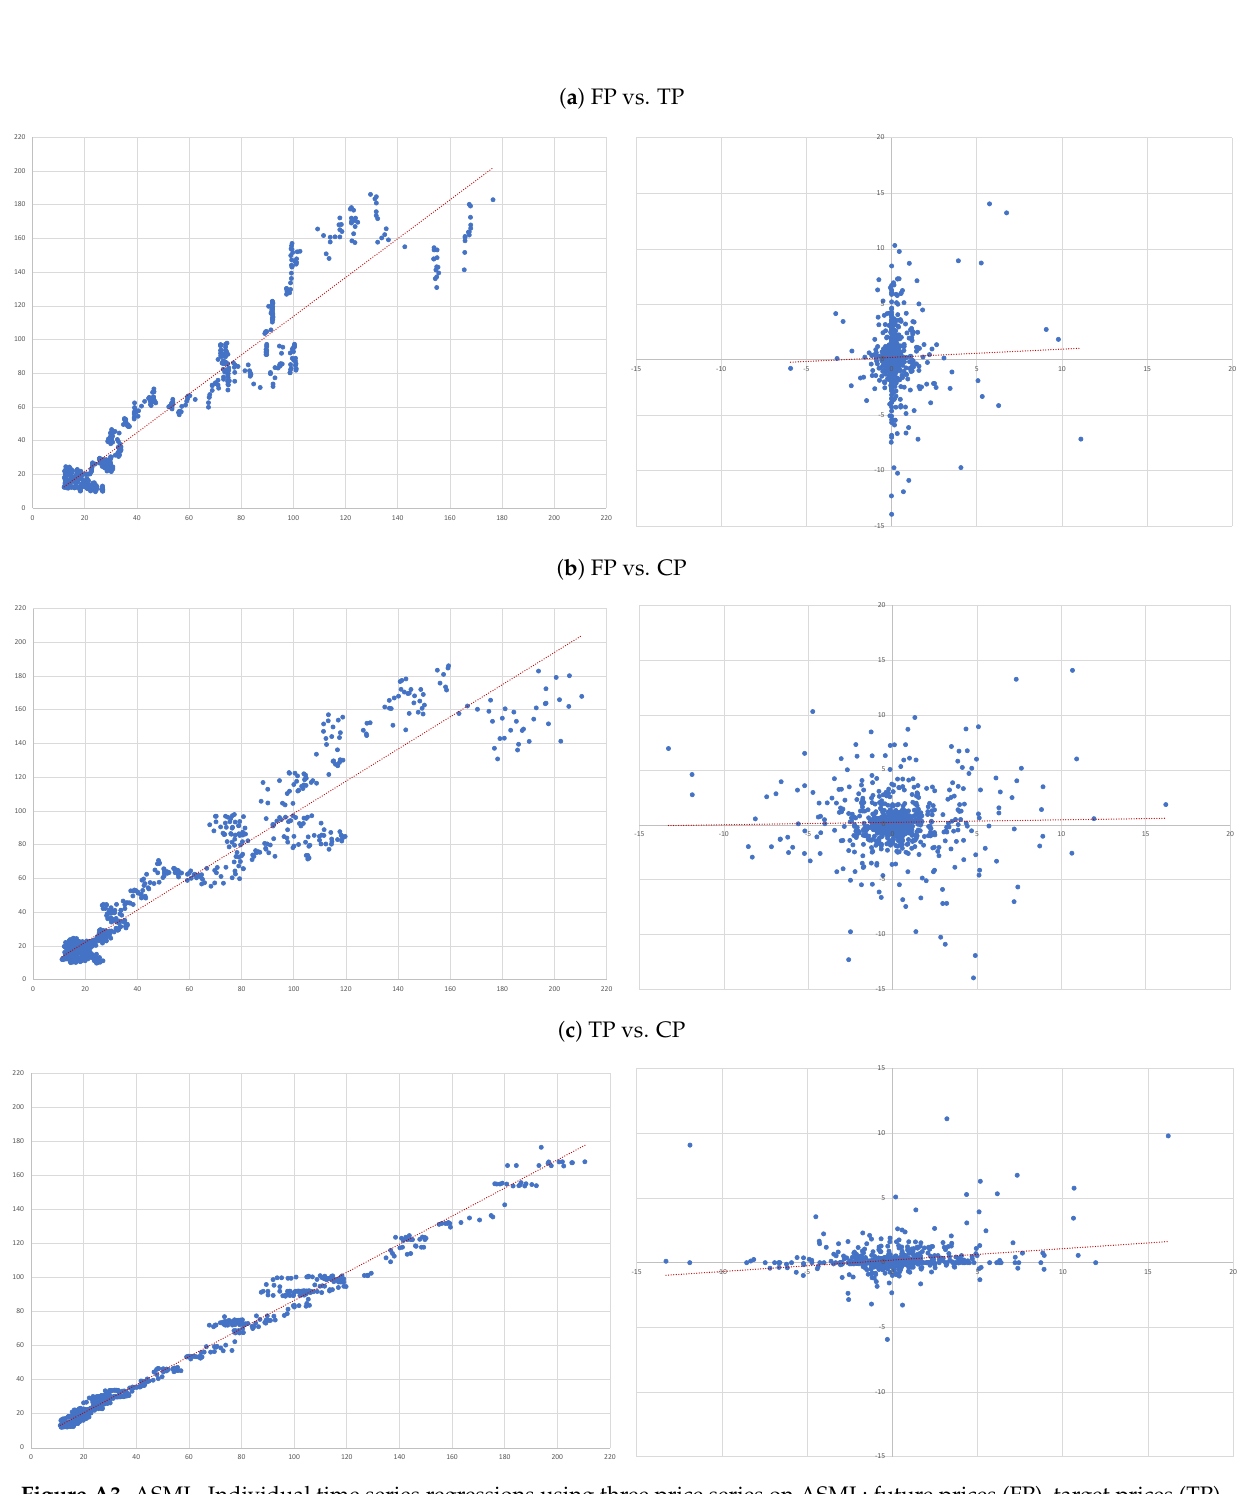
Figure A3. ASML. Individual time series regressions using three price series on ASML: future prices (FP), target prices (TP), and capitalised prices (CP) forecasts. On the left-hand-side are images of level regressions and on the right-hand-side are regressions in